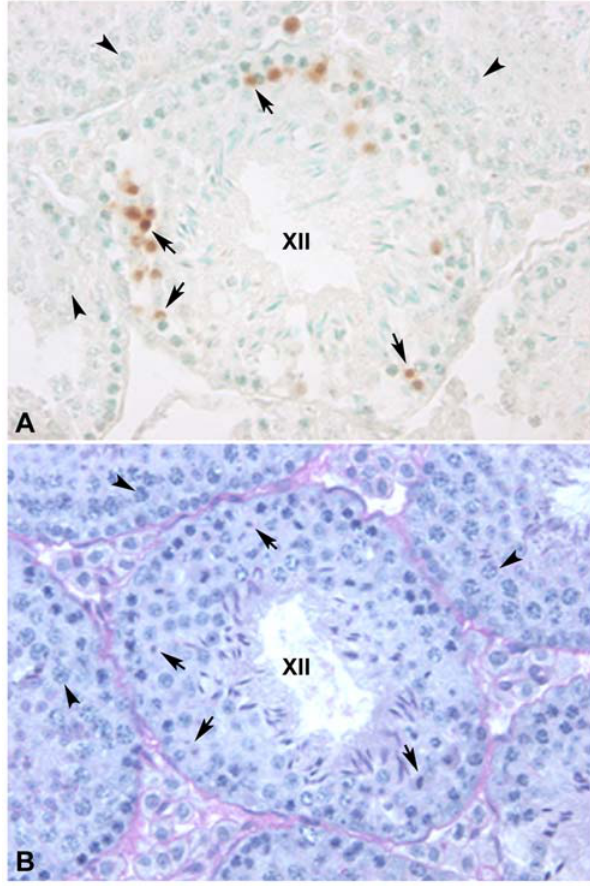
Figure 9. Cross-section of a stage XII tubule of the cycle of the seminiferous epithelium showing germ cell death of meiocytes in Robertsonian heterozygous mice. (A) Metaphases are the most frequent cell type positive to the TUNEL assay (arrows). Notice the absence of apoptotic cells in the surrounding tubules that are at different stages of seminiferous epithelium, and contain abundant pachytene spermatocytes (arrowheads). (B) Periodic-acid-Schiff (PAS) reaction and haematoxylin counterstaining of the same tubule cross- section.